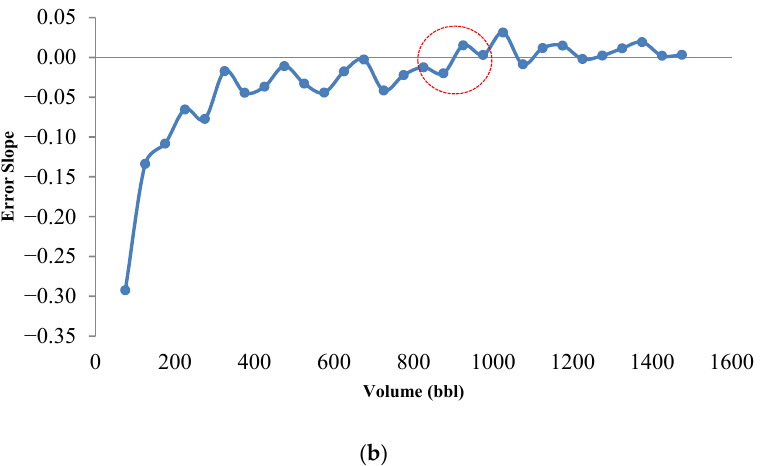
Figure 8. Minimum computational error for a given volume ( a ). Error derivative changes versus acid volume ( b ).